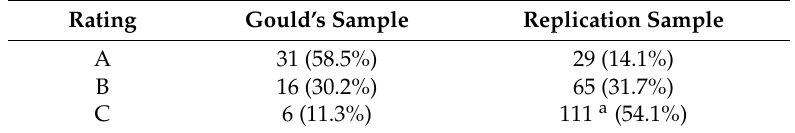
Table 2. Army Beta Intelligence Ratings for Gould’s Sample [1] and the Replication